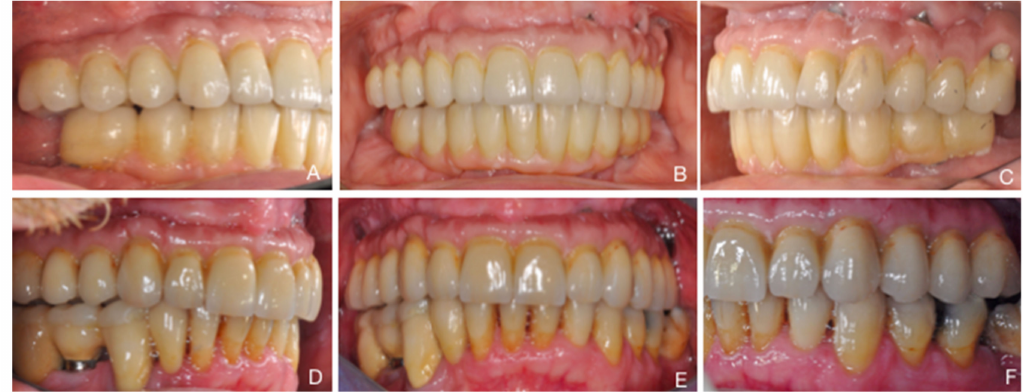
Figure 2. Clinical views, frontals and laterals, of fixed full-arch FDPs. ( A – C ) Short implant group. ( D – F ) Control implant group, with sinus floor